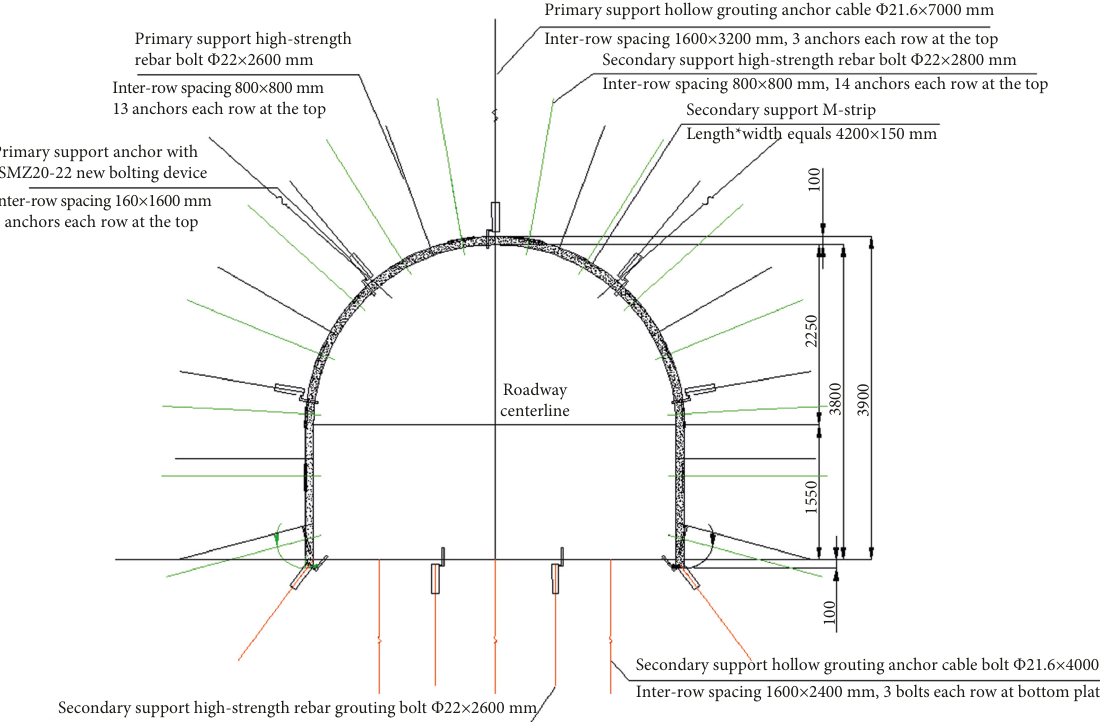
Figure 1: Full-section of bolt-net-cable-grout coupling support.